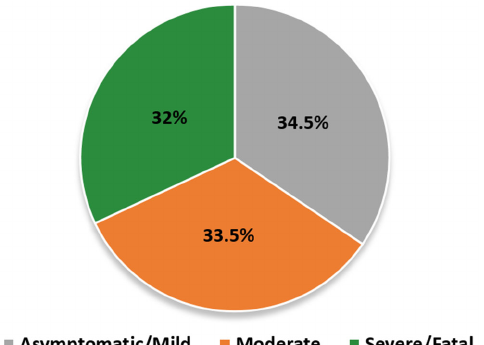
Figure 1. Demographic characteristics of the studied cohort. SARS-CoV-2-infected subjects were positive with quantitative RT-PCR tests. The clinical manifestations were classified into three categories: asymptomatic/mild (grey, 69 patients, 34.5%), moderate (orange, 67 patients, 33.5%), severe/fatal (green, 64 patients, 32%). Table 1. Clinical characteristics of the COVID-19 patient cohort.